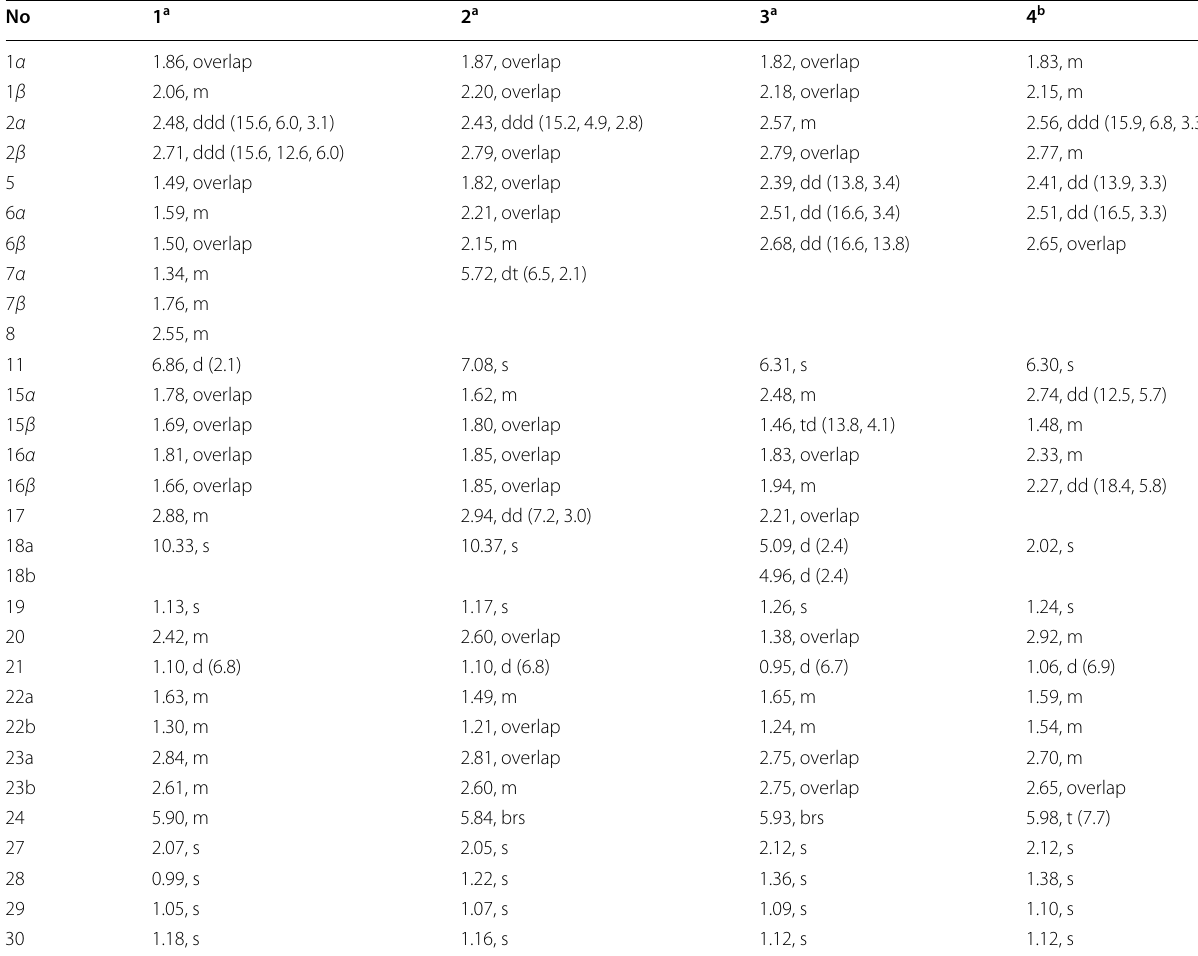
Table 1 1 H NMR data of compounds 1 – 4 ( δ in ppm, J in